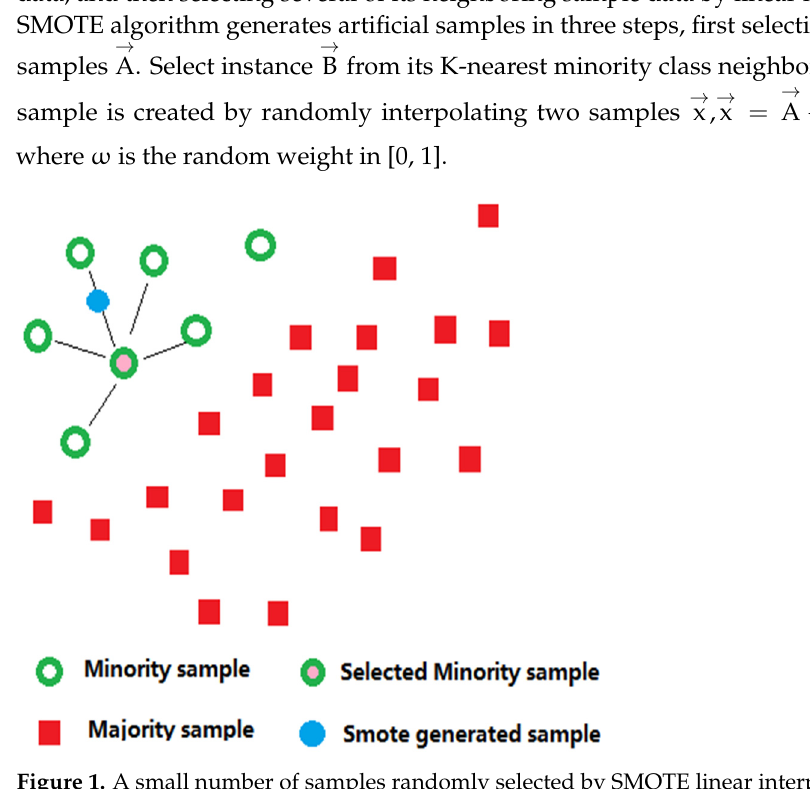
Figure 1. A small number of samples randomly selected by SMOTE linear interpolation and one of its k = 5 nearest its k = 5 nearest neighbors.